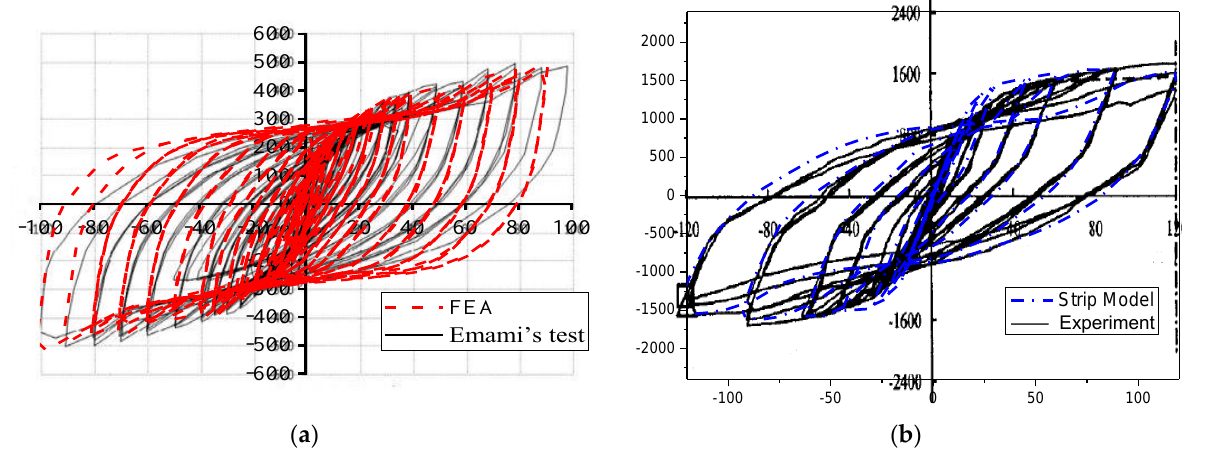
Figure 5. Validation of the finite element analysis: ( a ) validation of CoSPSW model, ( b ) validation of SPSW model.